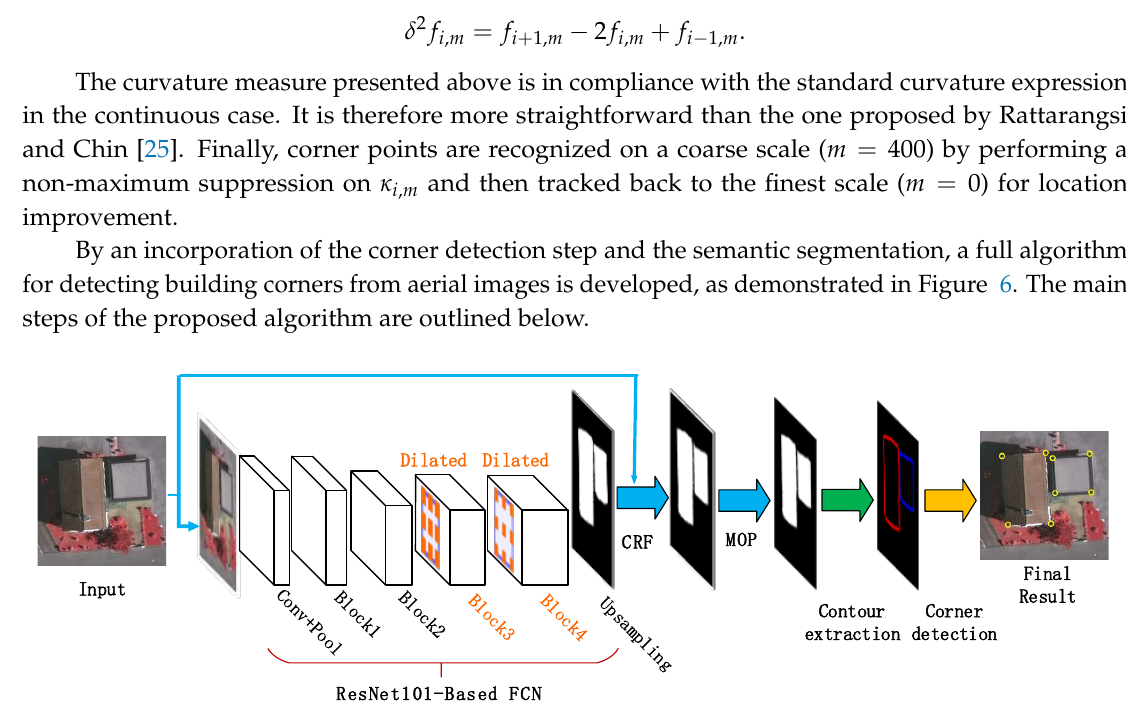
Figure 6. A global view of our proposed building corner